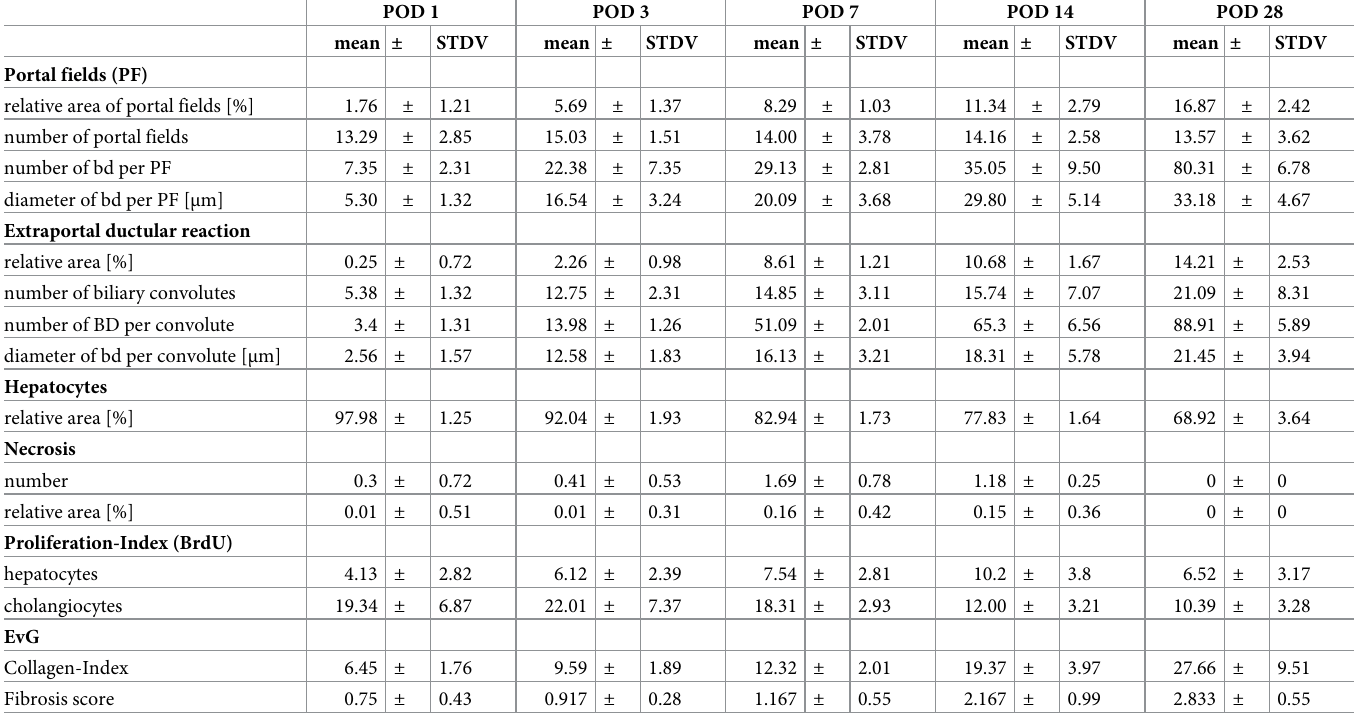
Table 4. Morphology and results of immunohistochemistry (HE, BrdU, EVG) after tBDT in rats. POD 1